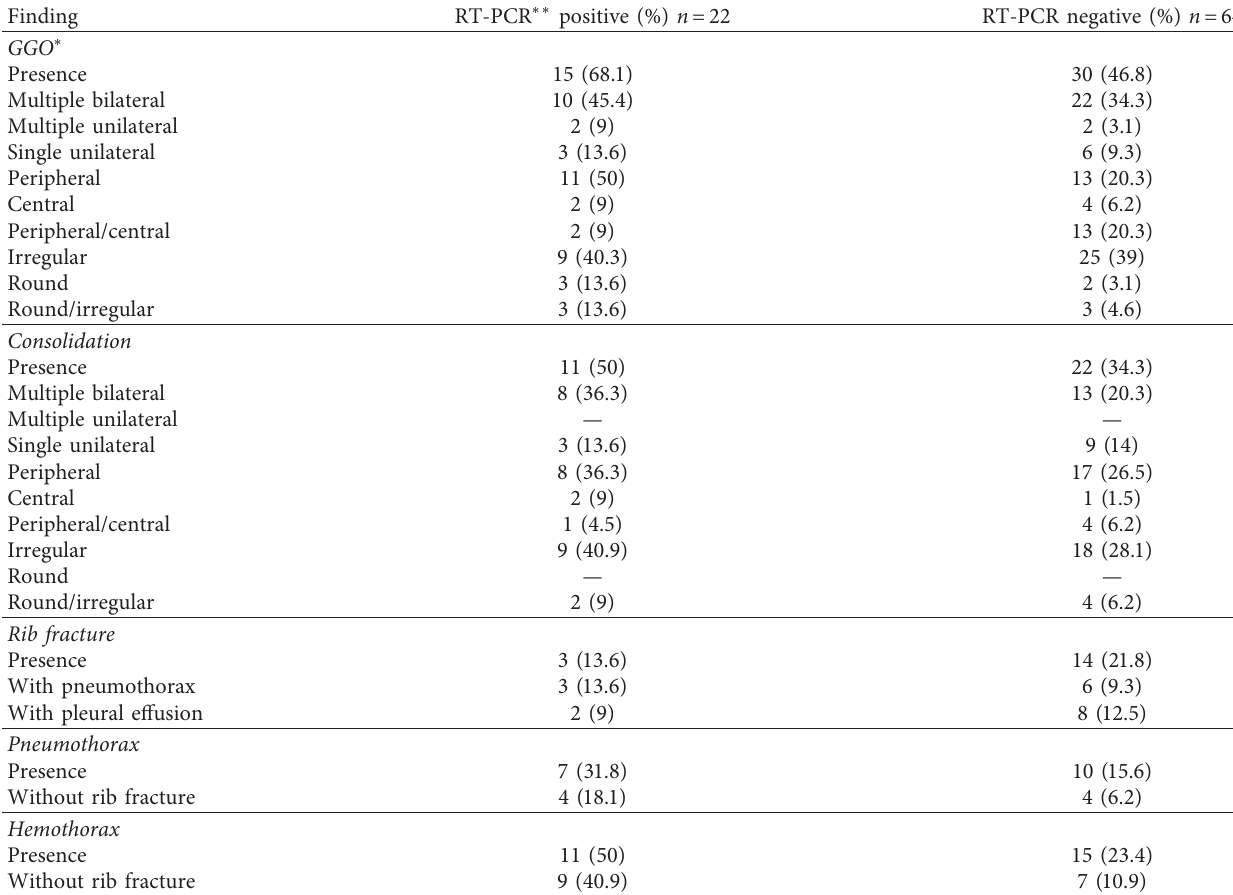
Table 3: Incidence of different RSNA classification features in definite and noninfected